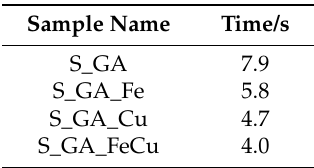
Table 5. Time Necessary to Spread a Water Drop on a